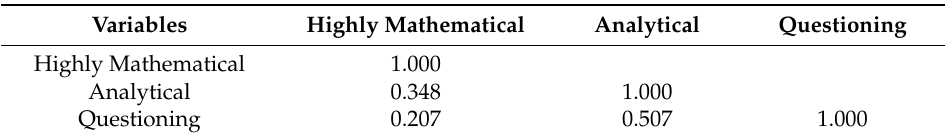
Table A4. Pearson’s Zero-Order Correlation Coefficients from Bivariate Pairs of Skill Scale Traits Describing Successful Tech Workers (Simard et al. 2007).